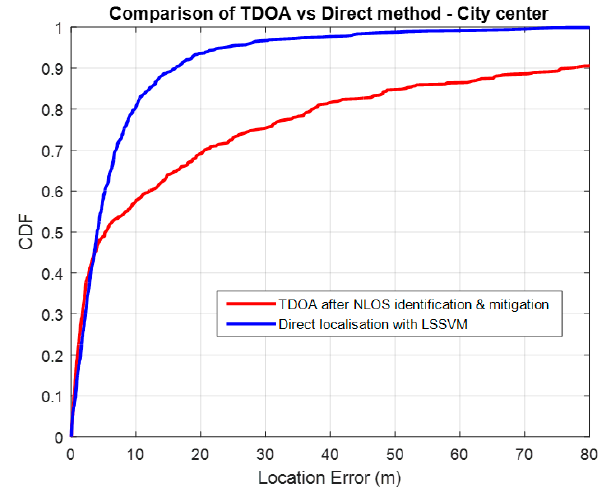
Figure 9. TDOA vs. Direct method in an urban